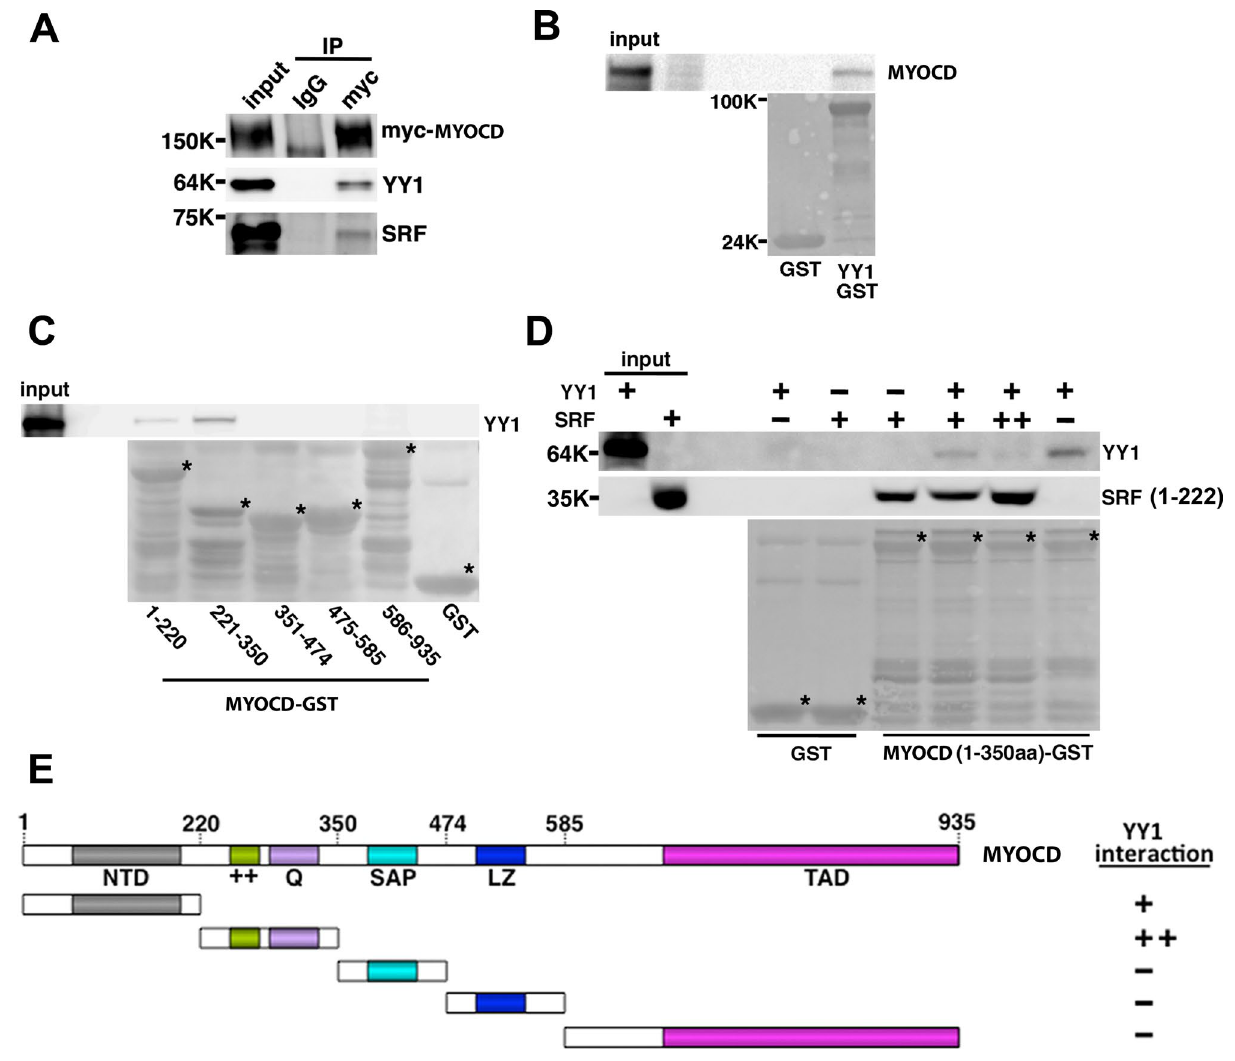
Figure 6. YY1 interacts with MYOCD to compete for the binding to SRF. ( A ) Expression plasmids encoding myc-Myocd were transfected into PAC1 cells. Nuclear protein lysates were extracted and used for co-immunoprecipitation assays using anti-myc antibody or control IgG. The presence of YY1 and SRF in immunoprecipitates were detected by Western blot using antibody against YY1 and SRF, respectively. ( B ) GST pull-down assay was performed using bacterial expressed T7 tagged full-length MYOCD to incubate with GST beads conjugated GST-YY1 or GST alone. ( C ) MYOCD-truncation GST fusion proteins (1–220 and 221–350), not the GST protein, pulled-down T7-tagged YY1. ( D ) GST and MYOCD(1–350)-GST were used to pull down YY1 and SRF (1–222). Western blot was performed using YY1 or SRF antibodies as indicated. Increased amount of SRF reduced YY1 binding to MYOCD. * indicates the GST fusion protein detected by Coomassie staining. ( E ) A schematic diagram shows domains of MYOCD required for YY1 interaction as revealed by GST pull down assays. The uncropped original western blots for panel 6A-6D are presented in Supplementary Figure S4A-S4D,